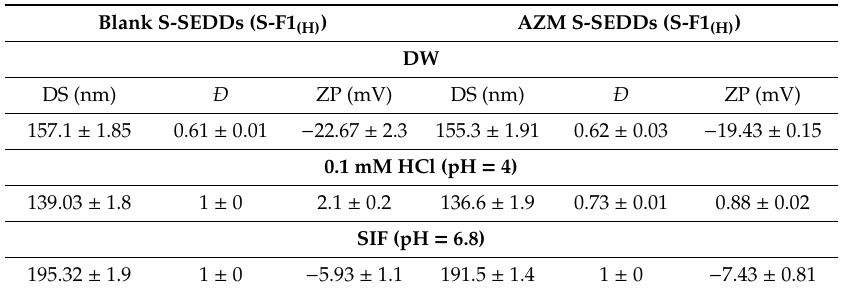
Table 7. Characterization of the optimized blank and AZM loaded S-F1(H) formulations in DW, 0.1 mM HCl, and SIF diluents. Mean ± SD, n = 3.